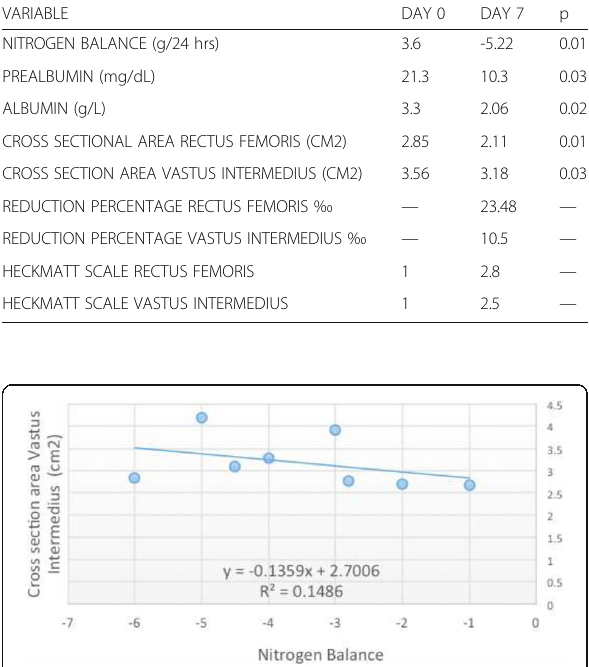
Fig. 1 (abstract 0220). Correlation between Nitrogen Balance and cross section area Vastus